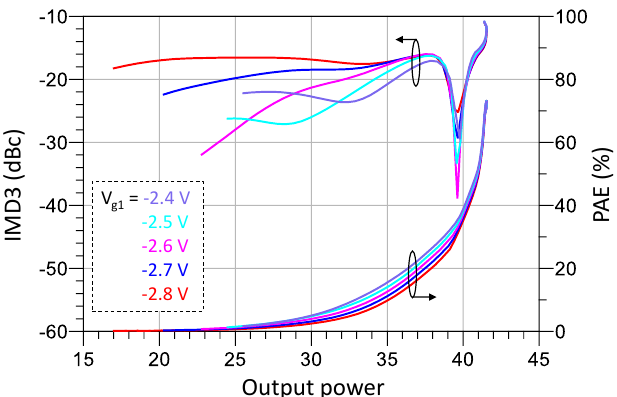
Figure 10. Large-signal (LS) investigation with V g1